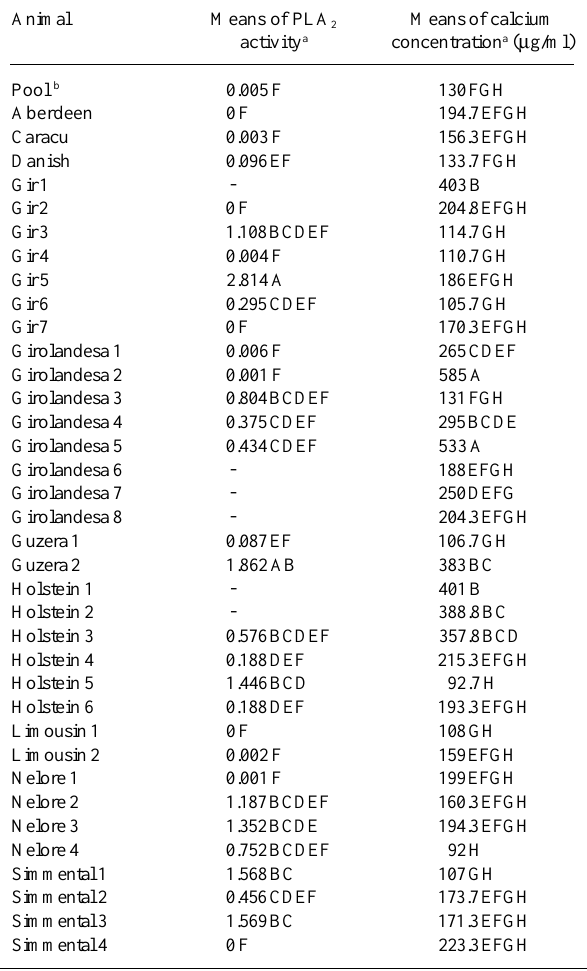
Table I - Analysis of variance of phospholipase A and calcium concentration of frozen bovine semen.